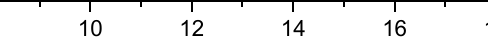
Figure 7. pH profile during period R1 for sewage sludge (SS) fed reactors.